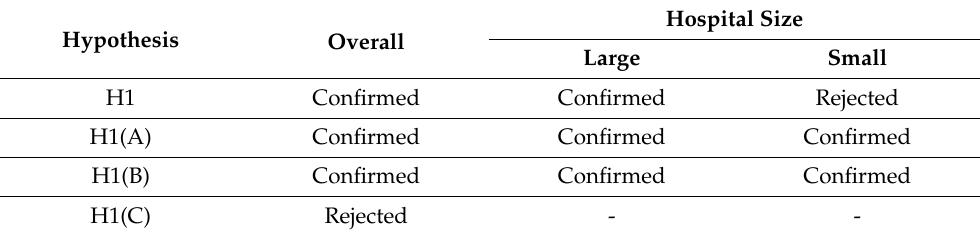
Table 4. Summary of the main